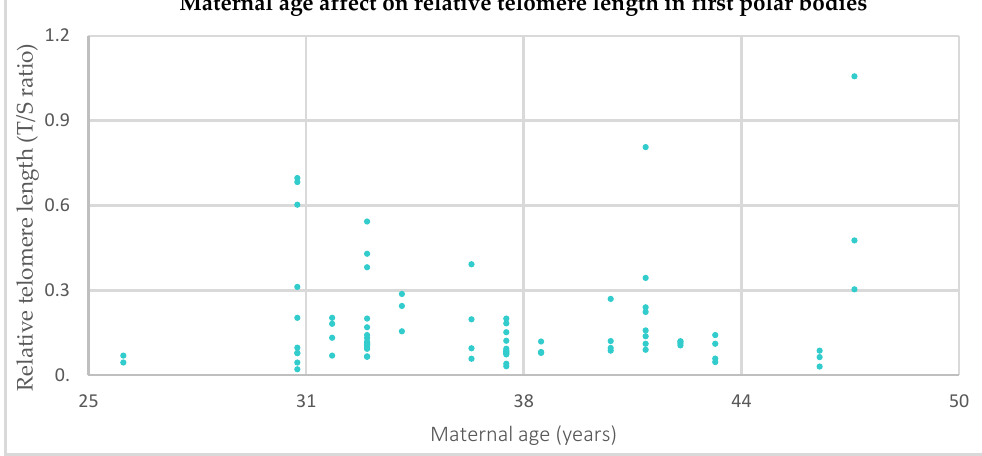
Figure 2. Relative telomere lengths of aneuploid and euploid first polar bodies in relation to maternal age ( n = 82 first polar bodies from n = 25 women). Results indicate no correlation between relative telomere length of first polar bodies and maternal age ( p = 0.52).